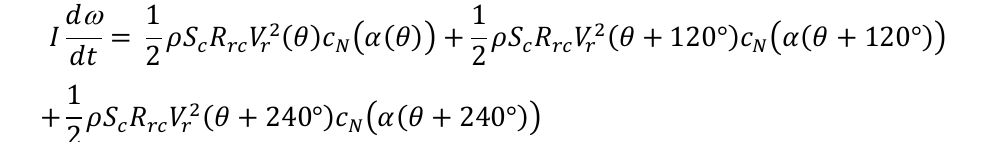
, of the Brevoort and Joyner Type-II N